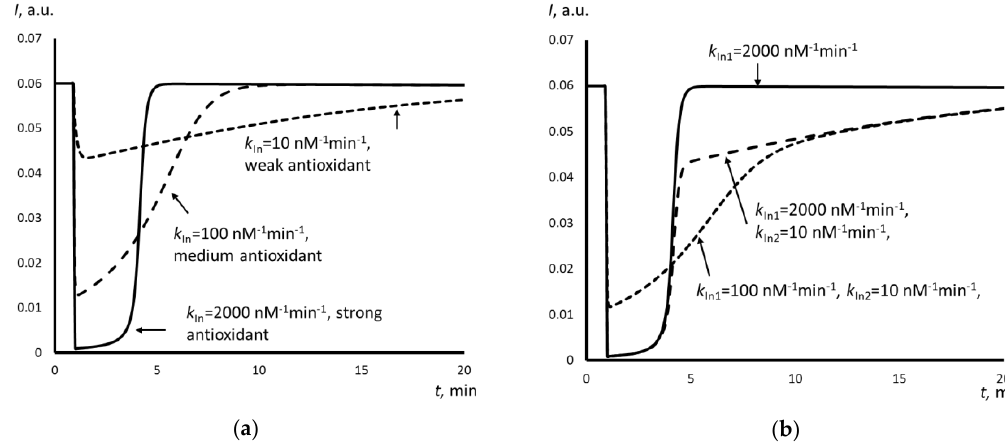
Figure 6. ( a ) The simulated chemiluminescence plots for the one-stage mechanism: solid line corresponds to a strong antioxidant, k In = 2000 nM − 1 min − 1 , dotted line — a medium antioxidant, k In = 100 nM − 1 min. − 1 , dashed line — a weak antioxidant, k In = 10 nM − 1 min. − 1 ; ( b ) the simulated chemiluminescence plots for the two-stage mechanism: solid line corresponds to a strong antioxidant, k In1 = 2000 nM − 1 min − 1 , dotted line — a strong antioxidant, k In1 = 2000 nM − 1 min. − 1 , k In2 = 10 nM − 1 min. − 1 , dashed line — a medium antioxidant, k In1 = 100 nM − 1 min. − 1 , k In2 = 10 nM − 1 min. − 1 .